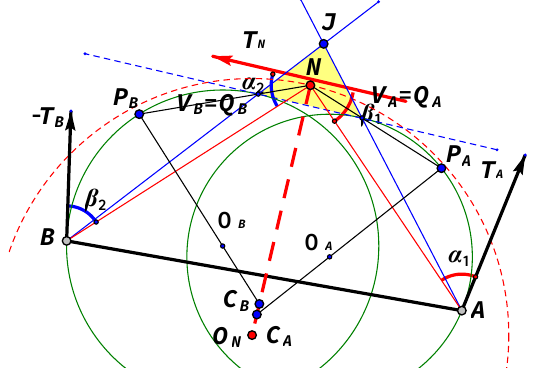
Figure 8. A simple geometric method to find O N . The point-inserting algorithm is given as Algorithm